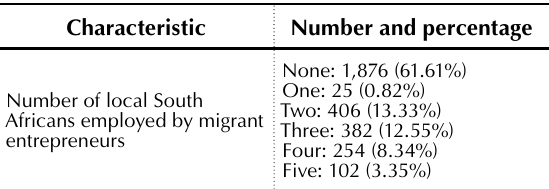
Table 5. Employment of local South Africans by migrant entrepreneurs ( n = 3,045)